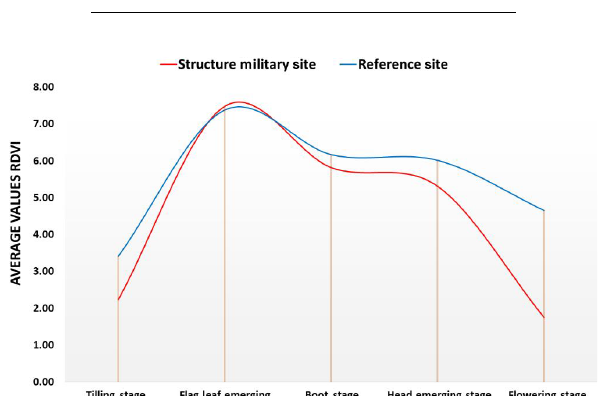
Figure 6. Same as Fig. 5, but for EVI.